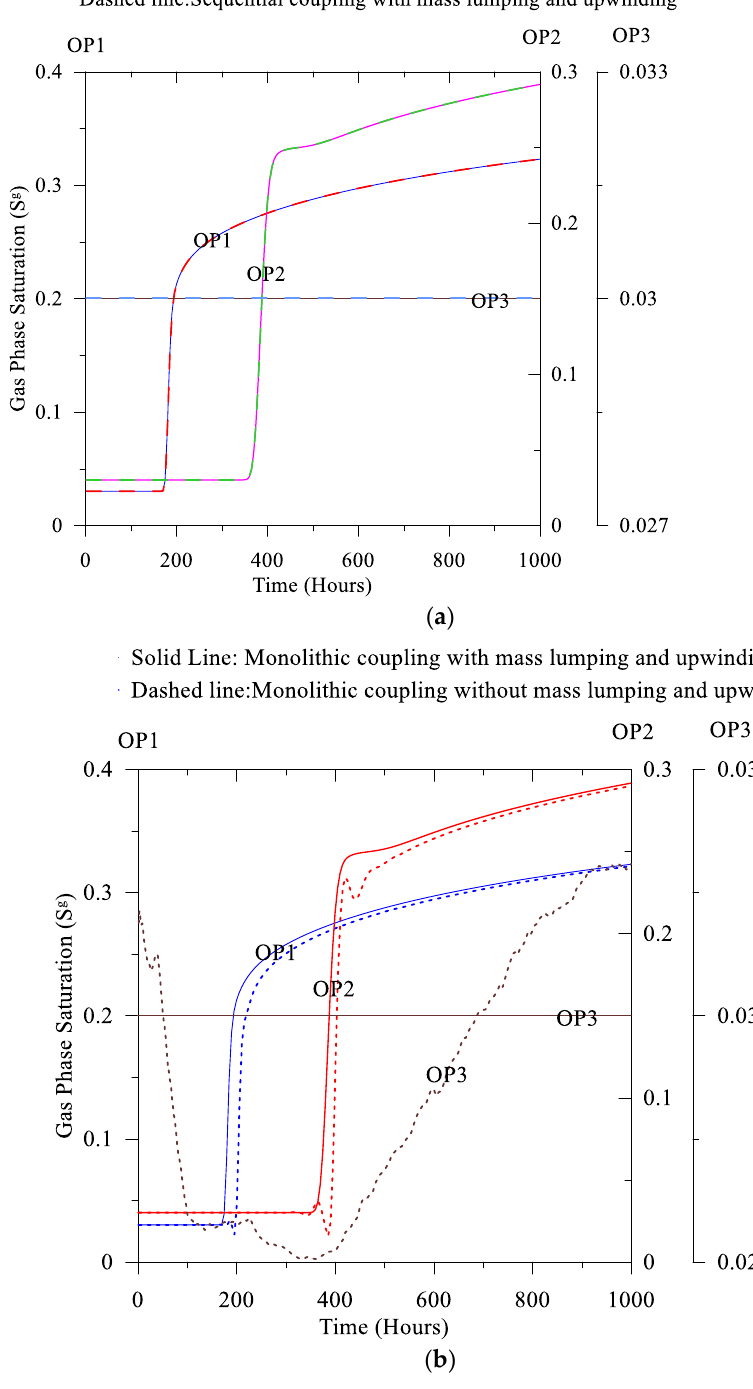
Figure 13. Comparisons of the gas phase saturation: ( a ) the monolithic coupling and the sequential coupling and ( b ) with and without the mass lumping and the upwinding.